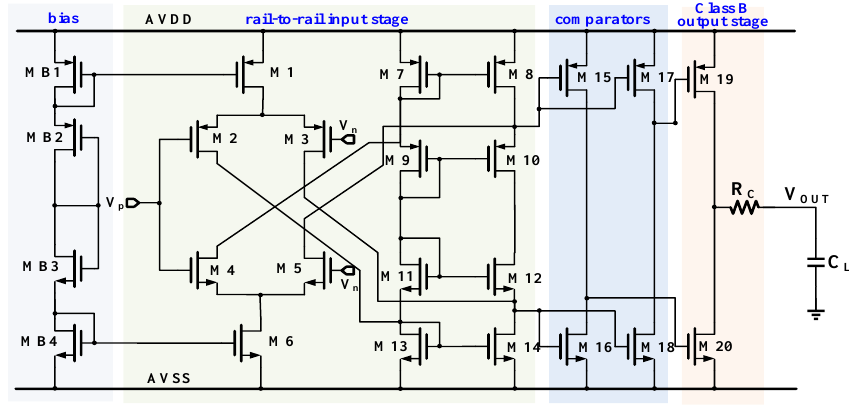
Figure 5. Schematic diagram of the rail-to-rail class-B output buffer.